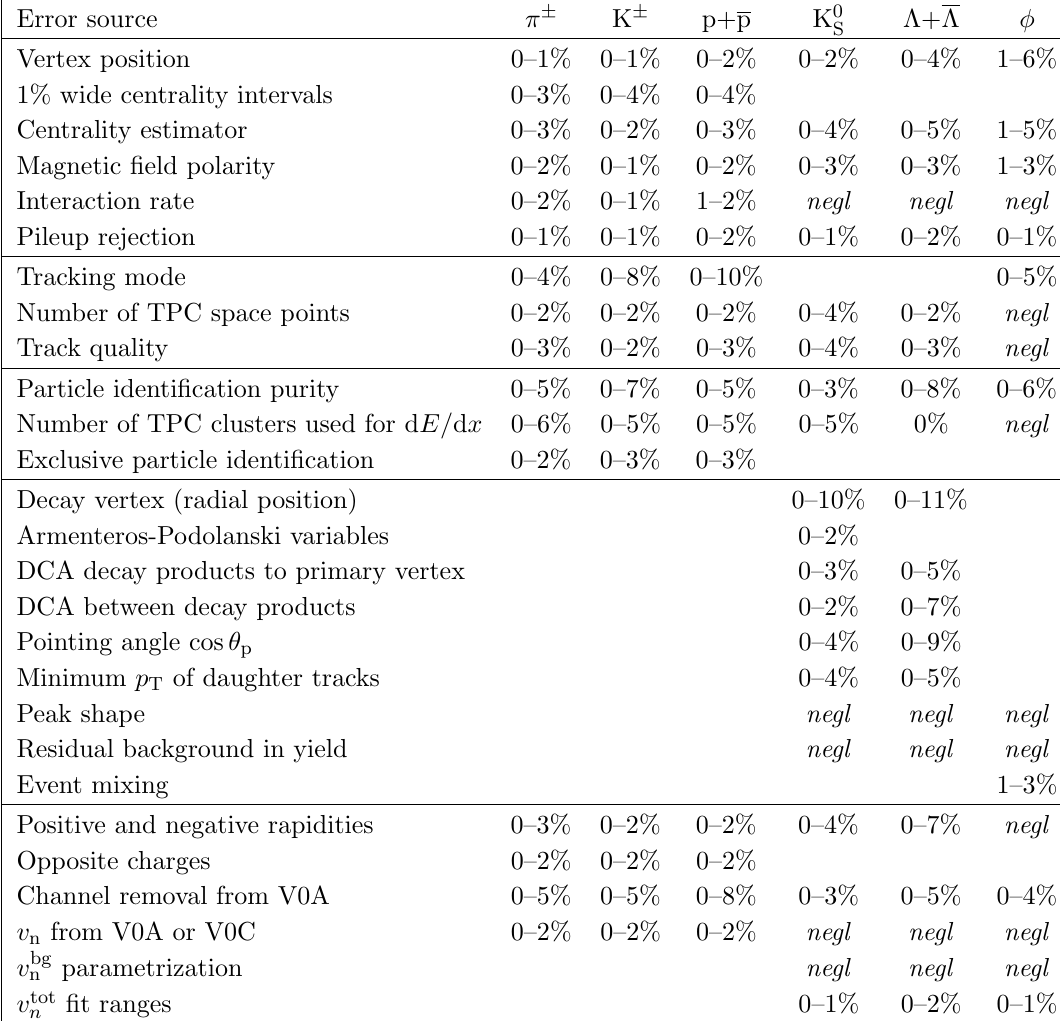
Table 1 . Summary of systematic uncertainties for the v 2 of (cid:25) (cid:6) , K (cid:6) , p+p, (cid:3)+(cid:3), K 0 (cid:30) -meson. The uncertainties depend on p T and centrality range; minimum and maximum values are listed here. Empty (cid:12)elds indicate that a given check does not apply to the particle of interest. If an uncertainty has been tested but cannot be resolved within statistical precision, the (cid:12)eld is marked negl for negligible. Horizontal lines are used to separate the di(cid:11)erent categories of systematic uncertainties as explained in section